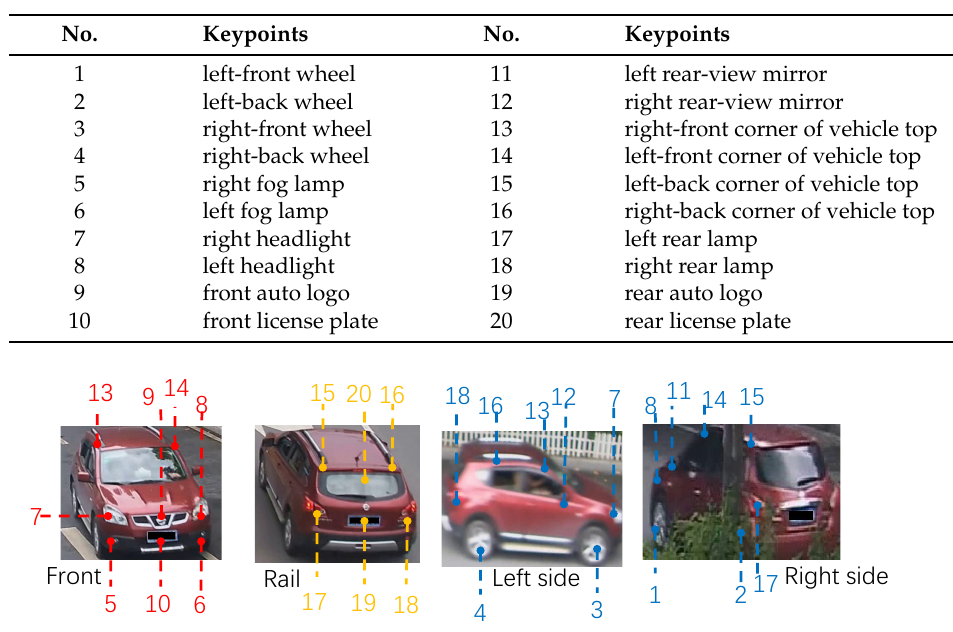
Figure 6. Illustrates four vehicle’s poses categories and the keypoint annotations at the vehicle. The numbers indicate the